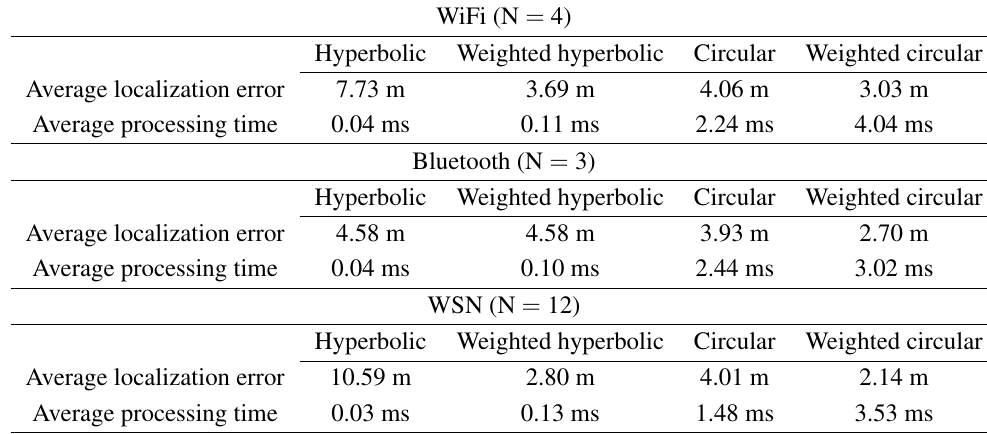
Table 1. Average localization error and average processing time for the different positioning algorithms in the three experiments.